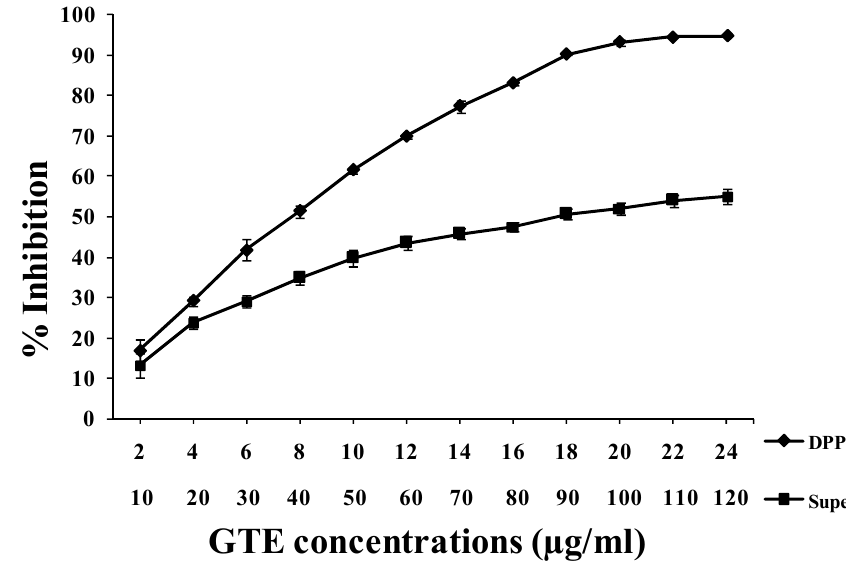
the phenazine methosulfate (PMS)-nicotinamide adenine dinucleotide (NADH) system by oxidation of NADH and assayed by the reduction of nitroblue tetrazolium (NBT). The results of these tests are expressed as the percent inhibition of the control (reagent without sample) that is calculated by Equations (1) and (2). For the DPPH • assay, the range of GTE concentrations used was 2–24 µg/mL. For the superoxide assay, the range of GTE concentrations used was 10–120 µg/mL. Data were obtained from three independent experiments. The mean and standard error were calculated for each concentration. IC values were 8.37 ± 0.14 and 91.34 ± 1.98 µg/mL for DPPH • and superoxide anion radicals,